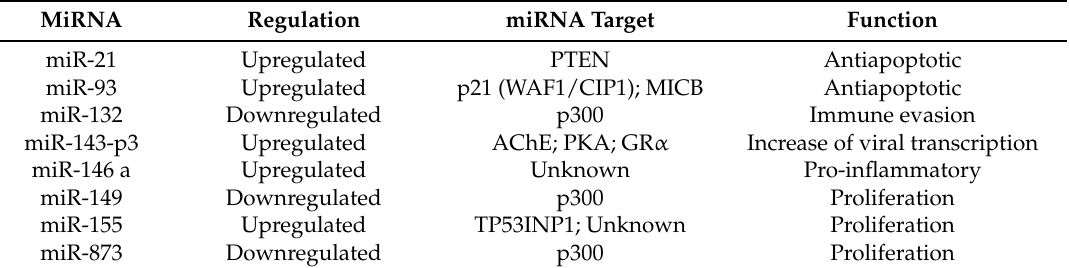
Table 2. Identified miRNAs and their biological effects on HTLV-1.